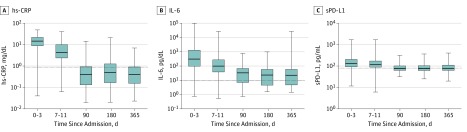
Inflammatory and Immunosuppression Biomarker Values Collected at Each Scheduled Collection Time PointHorizontal dotted lines represent the estimated 95th percentile of biomarker distribution among individuals without an infection. The lowest whisker indicates the minimum value; bottom border of the box, 25th percentile; line bisecting the shaded region of each box, median; top border of the box, 75th percentile; and highest whisker, maximum value. hs-CRP indicates highly sensitive C-reactive protein; IL, interleukin; and sPD-L1, soluble programmed death ligand 1.